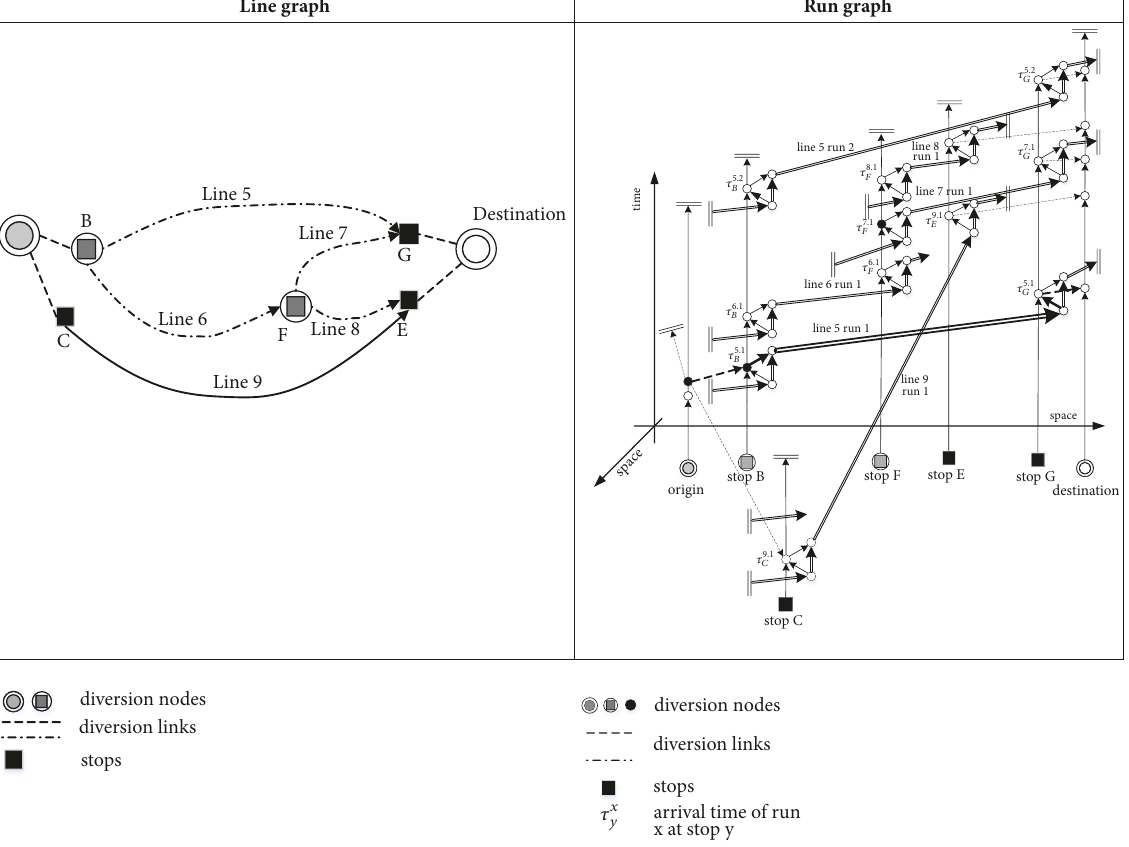
Figure 1: Example of line and diachronic